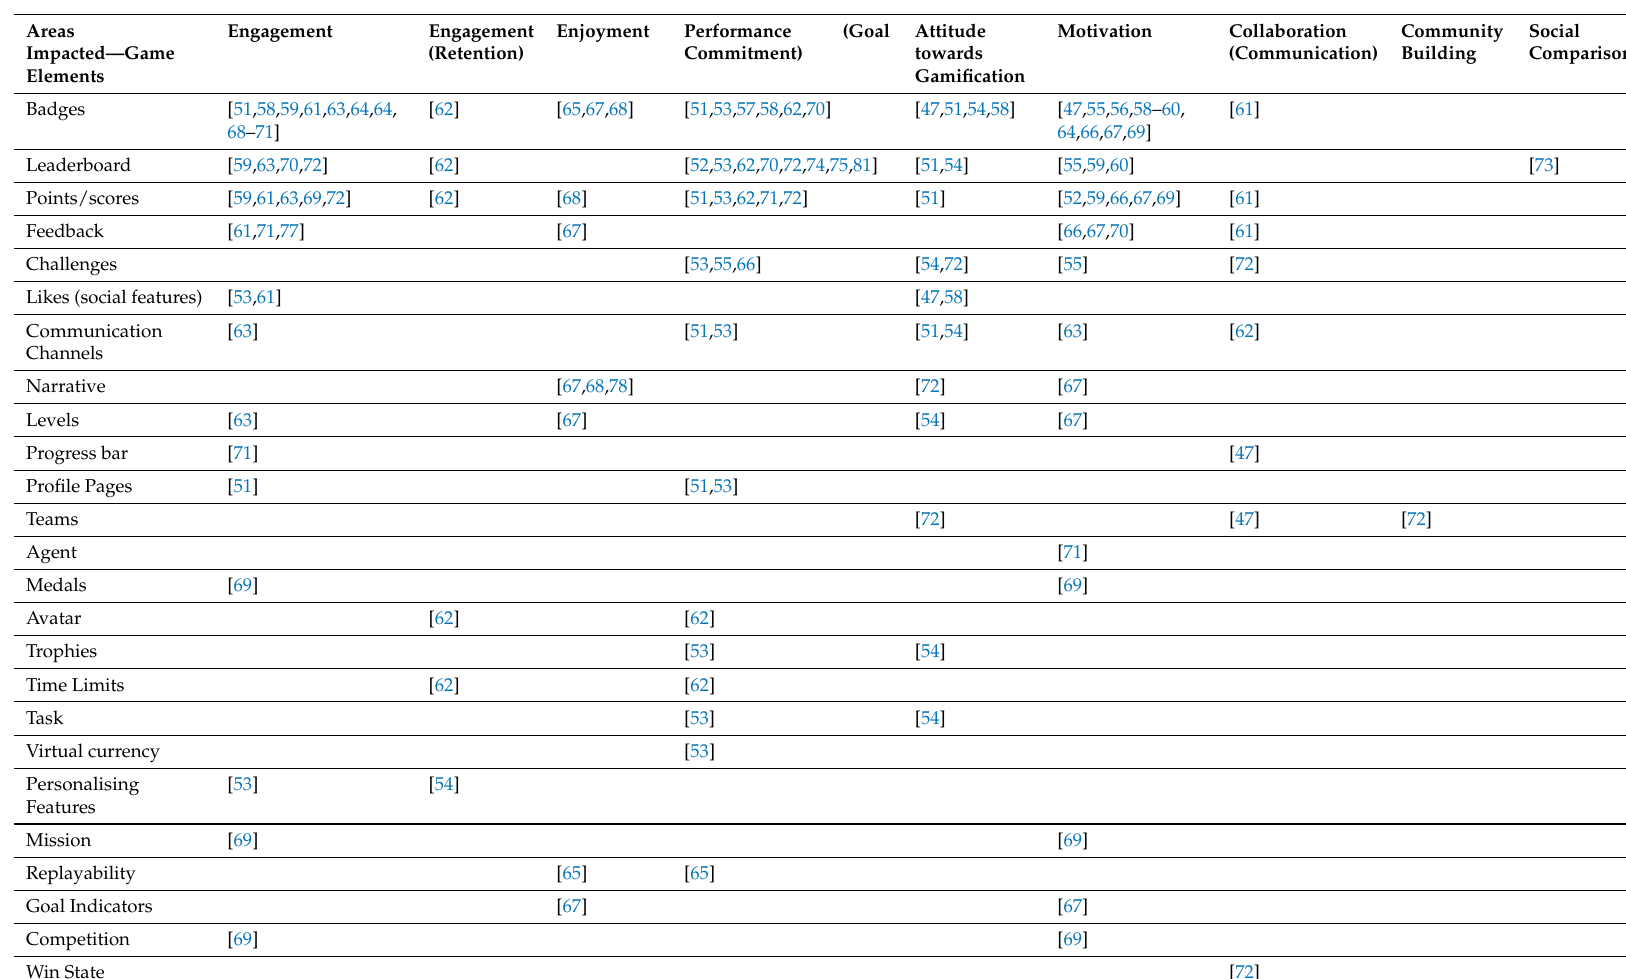
Table A4. The game elements applied in online learning and their effects